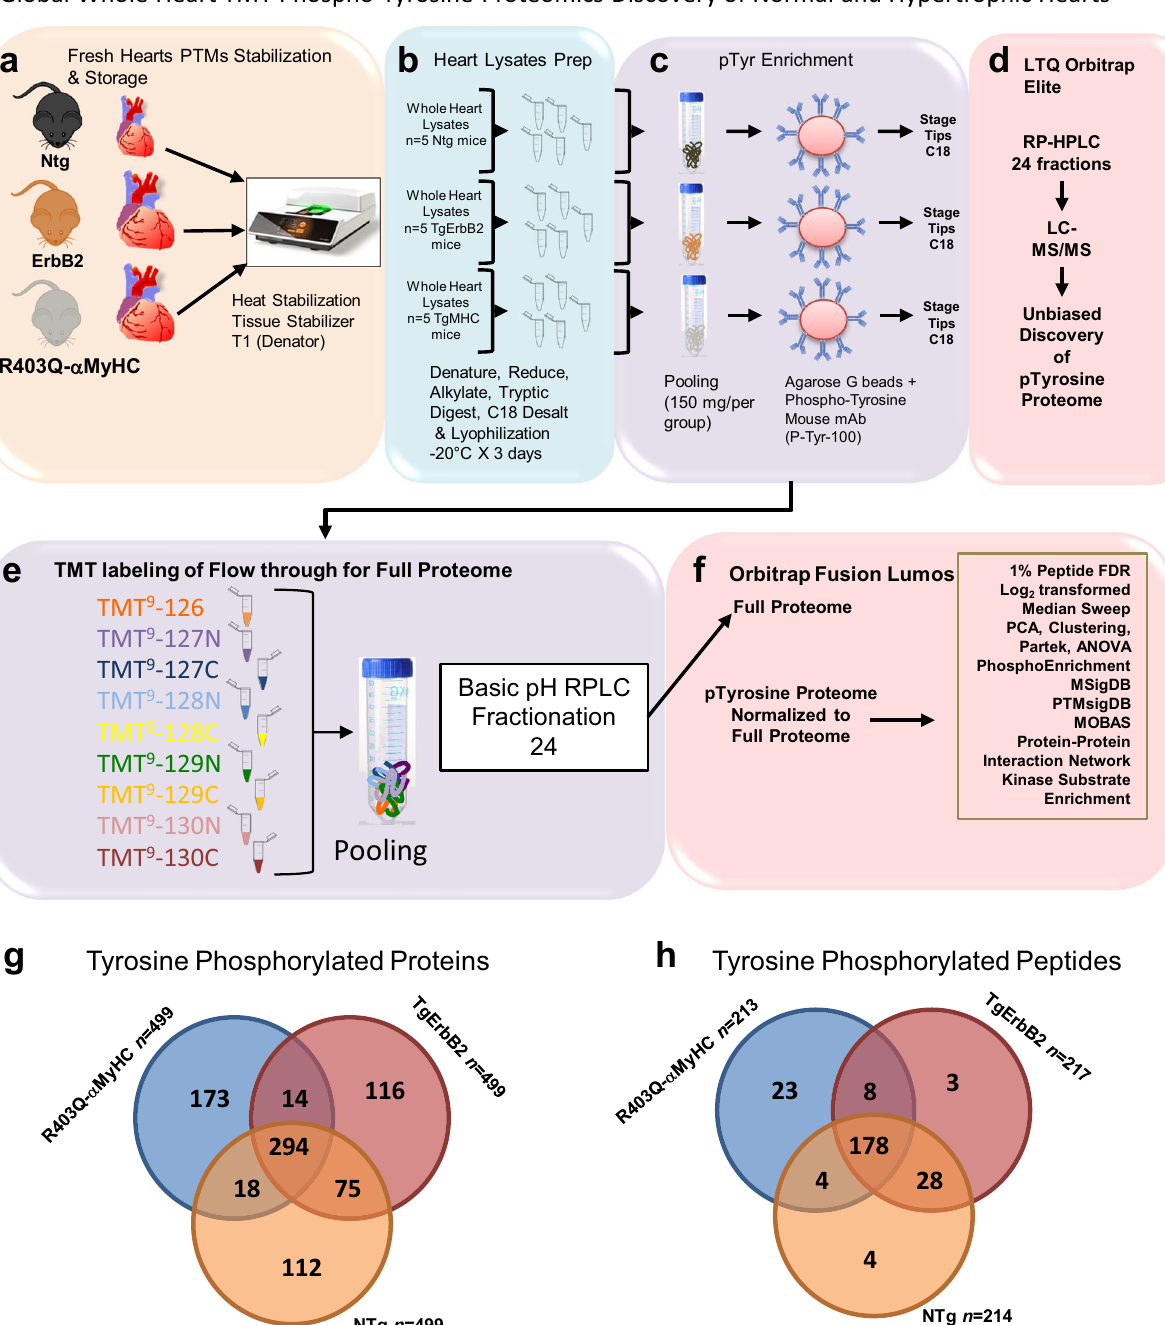
Fig. 2 Work fl ow for global whole heart TMT phospho-tyrosine proteomics pro fi ling. a Ventricular tissues were rinsed with PBS and subjected to Heat Stabilization using a T1 Tissue Stabilizor to maximize phosphorylation preservation, then snap-frozen in liquid nitrogen and stored at − 80 °C until further use. b Ntg, TgErbB2, and R403Q- α MyHC mice hearts ( n = 5 per group) were processed in parallel to obtain whole heart lysates; 30 mg of protein lysates were used from each mouse heart for in-solution trypsin digestion, a total of 150 mg of trypsinized protein per genotype were C18 desalted and lyophilized at − 20 °C for three days. c A total of 150 mg of tryptic peptides (pooled material from 5 hearts per group) were enriched for pTyrosine using immunoaf fi nity precipitation (Protein Agarose Beads + 300 micrograms of mAb Anti-pTyr) and desalted on C18 stage tips. d RP-HPLC ESI (electrospray ionization) MS/MS was performed on an LTQ Orbitrap Elite (Thermo Scienti fi c) for a 120 min on a linear acetonitrile gradient (4 − 40%). Raw data were searched with Mascot 2.3, and label-free quanti fi cation with MS1 extracted ion chromatograms were performed using MaxQuant. This approach was repeated three times with samples from all three groups running parallel; 15 hearts per genotype in three technical replicates. e A fraction of the fl ow- through of pTyr enrichment was used for a 9-plexTMT; three replicates of each genotype (Ntg, TgErbB2, and R403Q- α MyHC) were pooled, fractionated in RPLC for full proteome quanti fi cation, f Data from pTyrosine and Full Proteome were processed in a similar way, pTyrosine signals were normalized to matched total protein expression to normalize data. Analyses are detailed in the text and supplemental data. g Shows the overlap of phosphorylated proteins found in the three groups, whereas h shows the overlapping tyrosine-phosphorylated peptides among the three